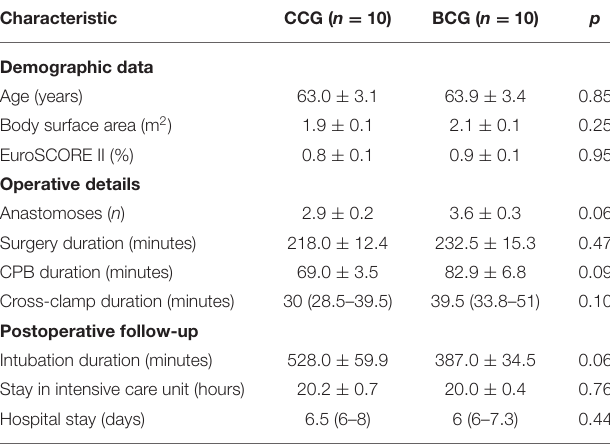
TABLE 1 | Characteristics of